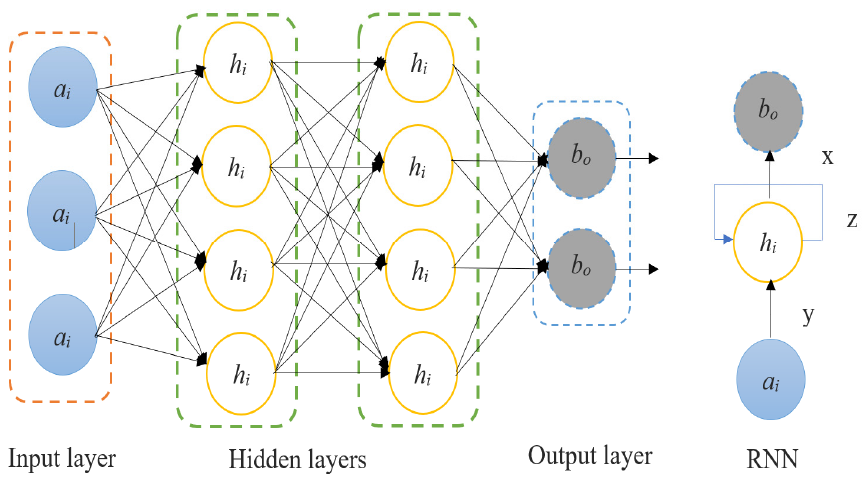
Figure 2. Recurrent neural